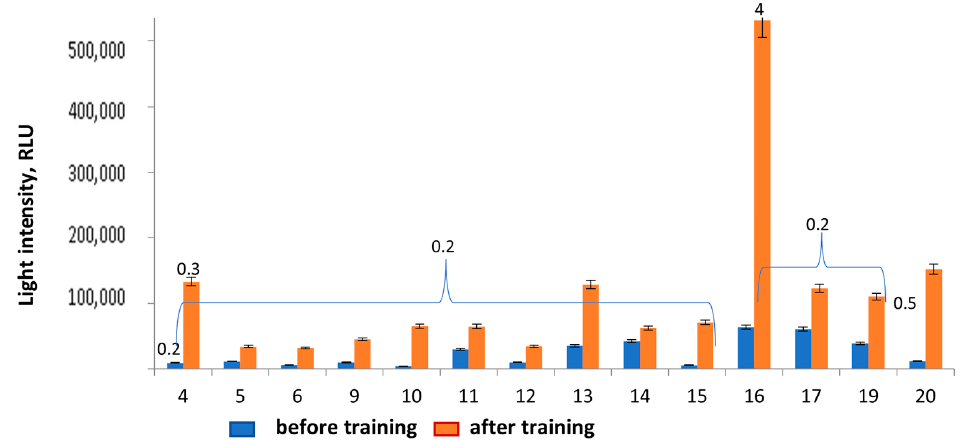
Figure 8. Effect of the saliva samples on the activity of the multi ‐ enzyme system. Numbers above the mean calculated salivary lactate concentrations.